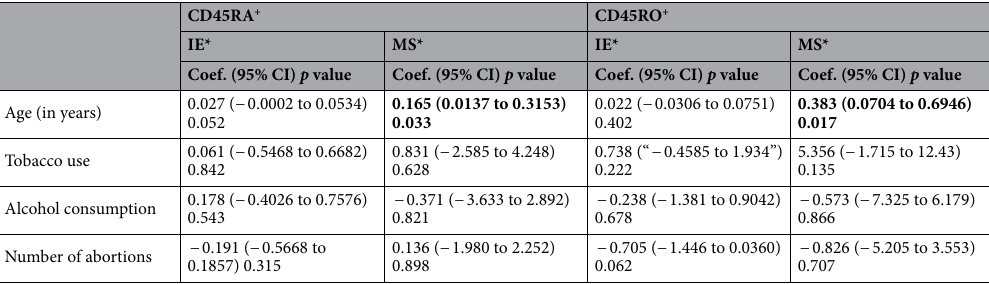
Table 2. Multiple linear regression analysis of CD45RA + and CD45RO + expressing cells. * IE intraepithelial, MS marginal stroma. The bold values mean statistical difference in the multiple linear regression